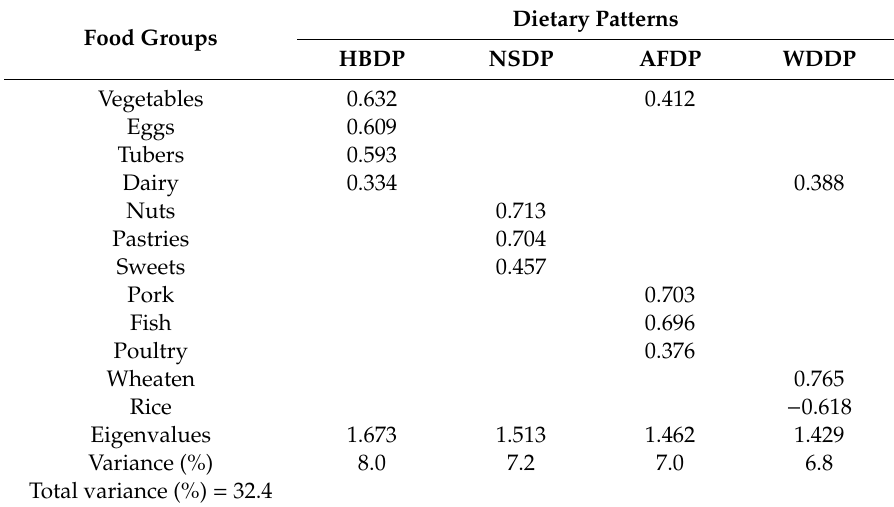
Table 4. Factor loadings for the four identified dietary patterns of the male